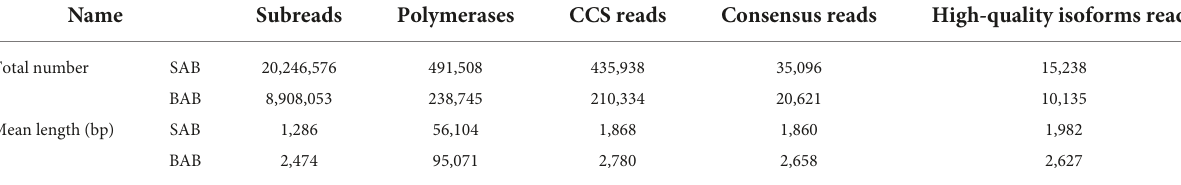
TABLE 2 Overview of the single-molecule real-time sequencing in H. ammodendron and H. persicum.